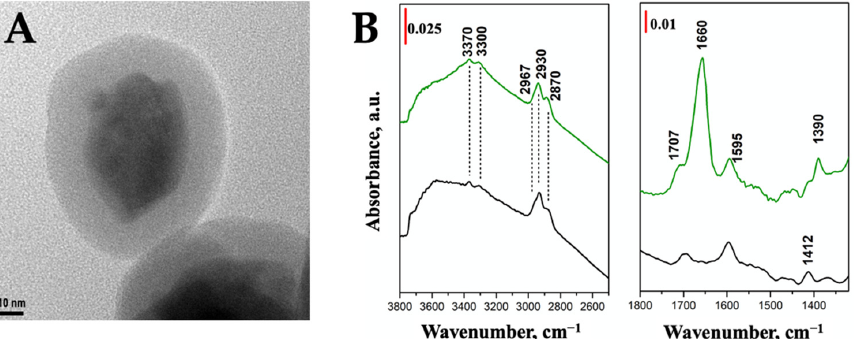
Figure 5. ( A ). TEM image of ZEY2@SiO 2 ; ( B ). FTIR spectra of ZEY2@SiO 2 (black curve) and ZEY2- Ver (green curves). (green